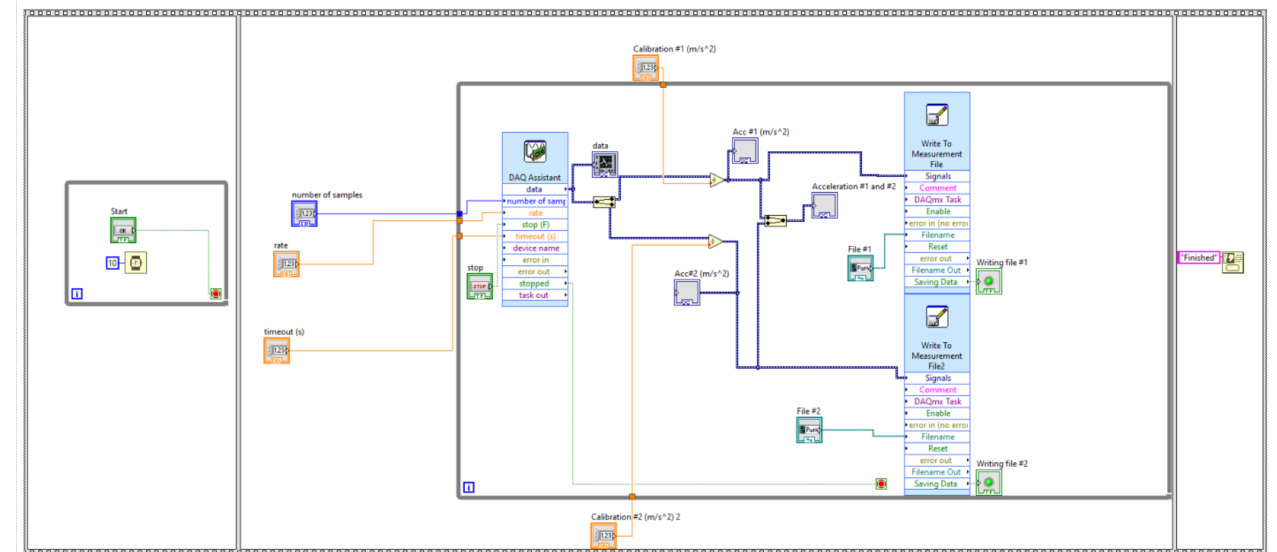
Figure 5. Vibration acquisition and processing